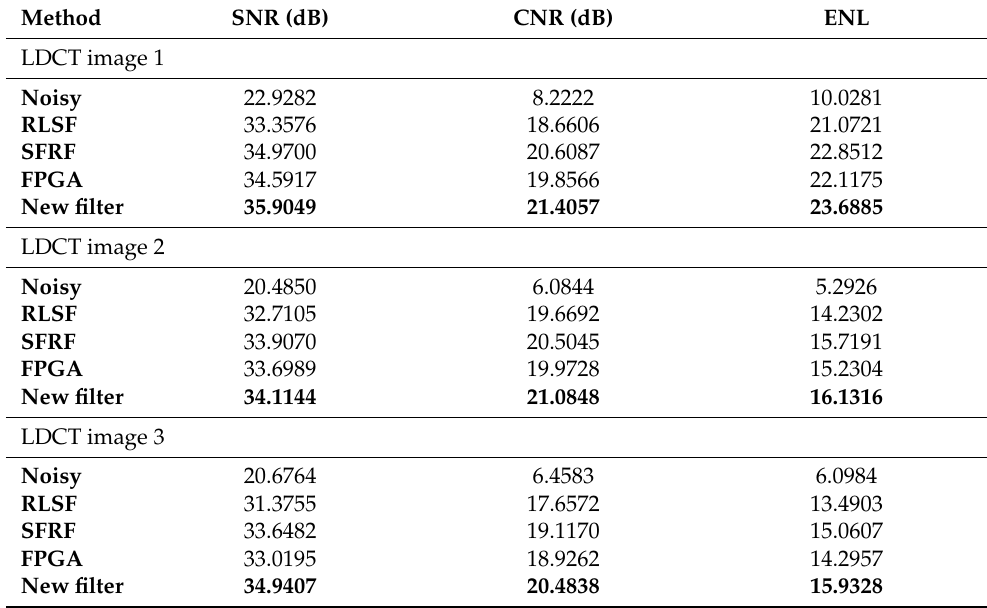
Table 5. SNR, ENL, and CNR measures for noisy low-dose CT images. Values in bold denote the best filtering